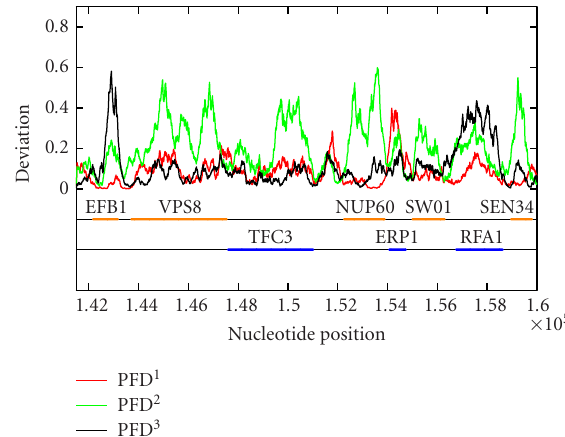
Figure 6. Period-3 fractal deviations (PFDs) of yeast chro- mosome I (a segment from nucleotide 141500 to nucleotide